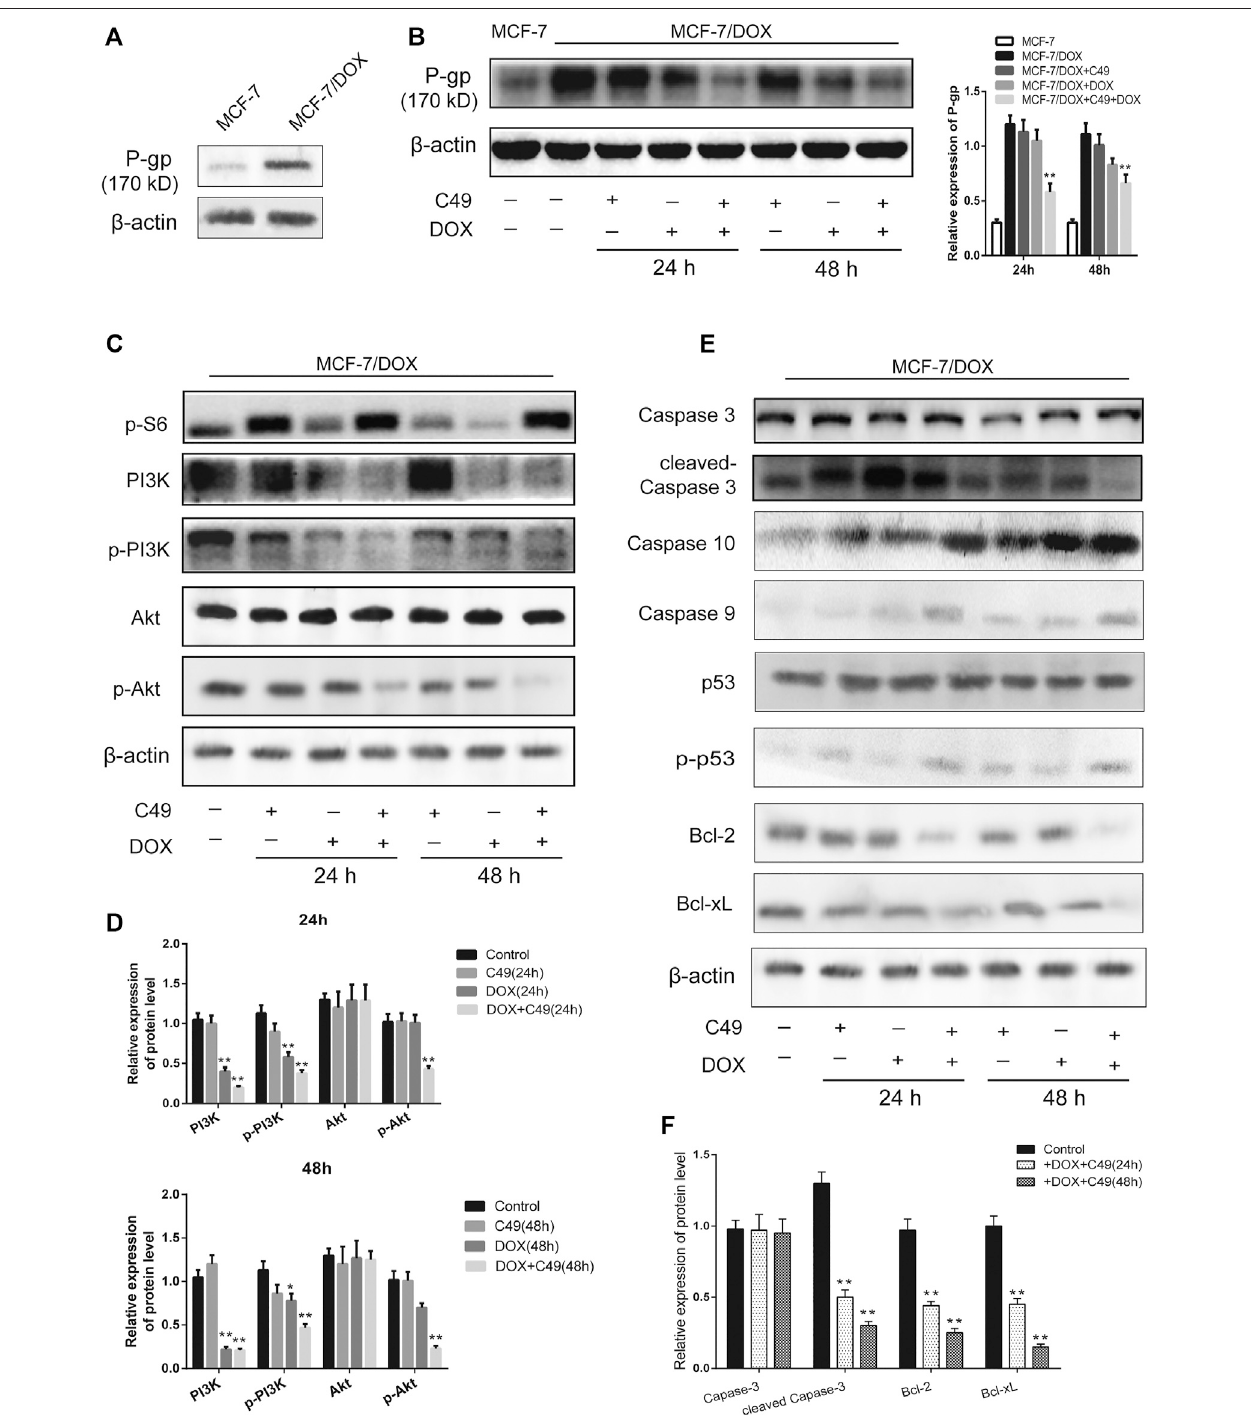
FIGURE 6 | The combination of C49 and DOX inhibited P-gp expression, apoptotic signaling pathway and the PI3K/Akt signaling pathway. (A) The P-gp expression in MCF-7 cells and MCF-7/DOX cells. (B – F) WB and quantitative analysis of P-gp, PI3K, p-PI3K, Akt, p-Akt, Caspase-3, Caspase-10, Caspase-9, p53, p-p53, Bcl-2, and Bcl-xL proteins expression compared with β -actin. * p < 0.05, ** p < 0.01 vs. MCF-7/DOX cells.